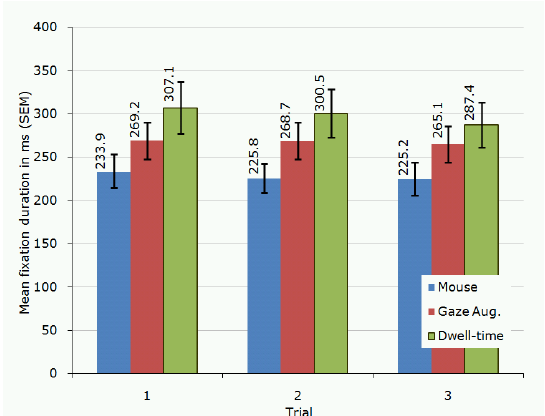
Figure 5 . Mean fixation duration for each trial and interaction